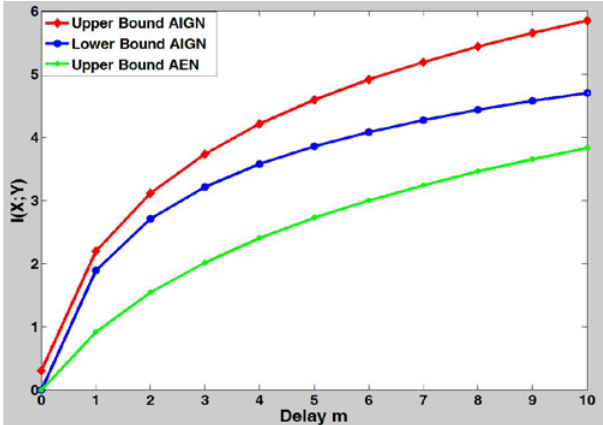
Figure 2: Upper and lower bound of capacity of the molecular relay channel as a function of the delay constraint. The drift velocity has been set to v = 2, 1, 1.5 for C TR , C TM , C MR and the channel parameter λ is assumed to be 0.25. Upper bound of the capacity for the AEN channel is shown as a green line. The mean of exponential noise b is set to 2.